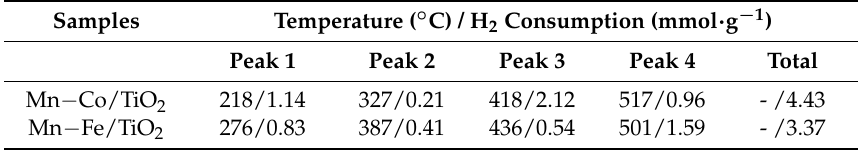
Table 2. H 2 -TPR quantitative analysis of Mn − Co/TiO 2 and Mn − Fe/TiO 2